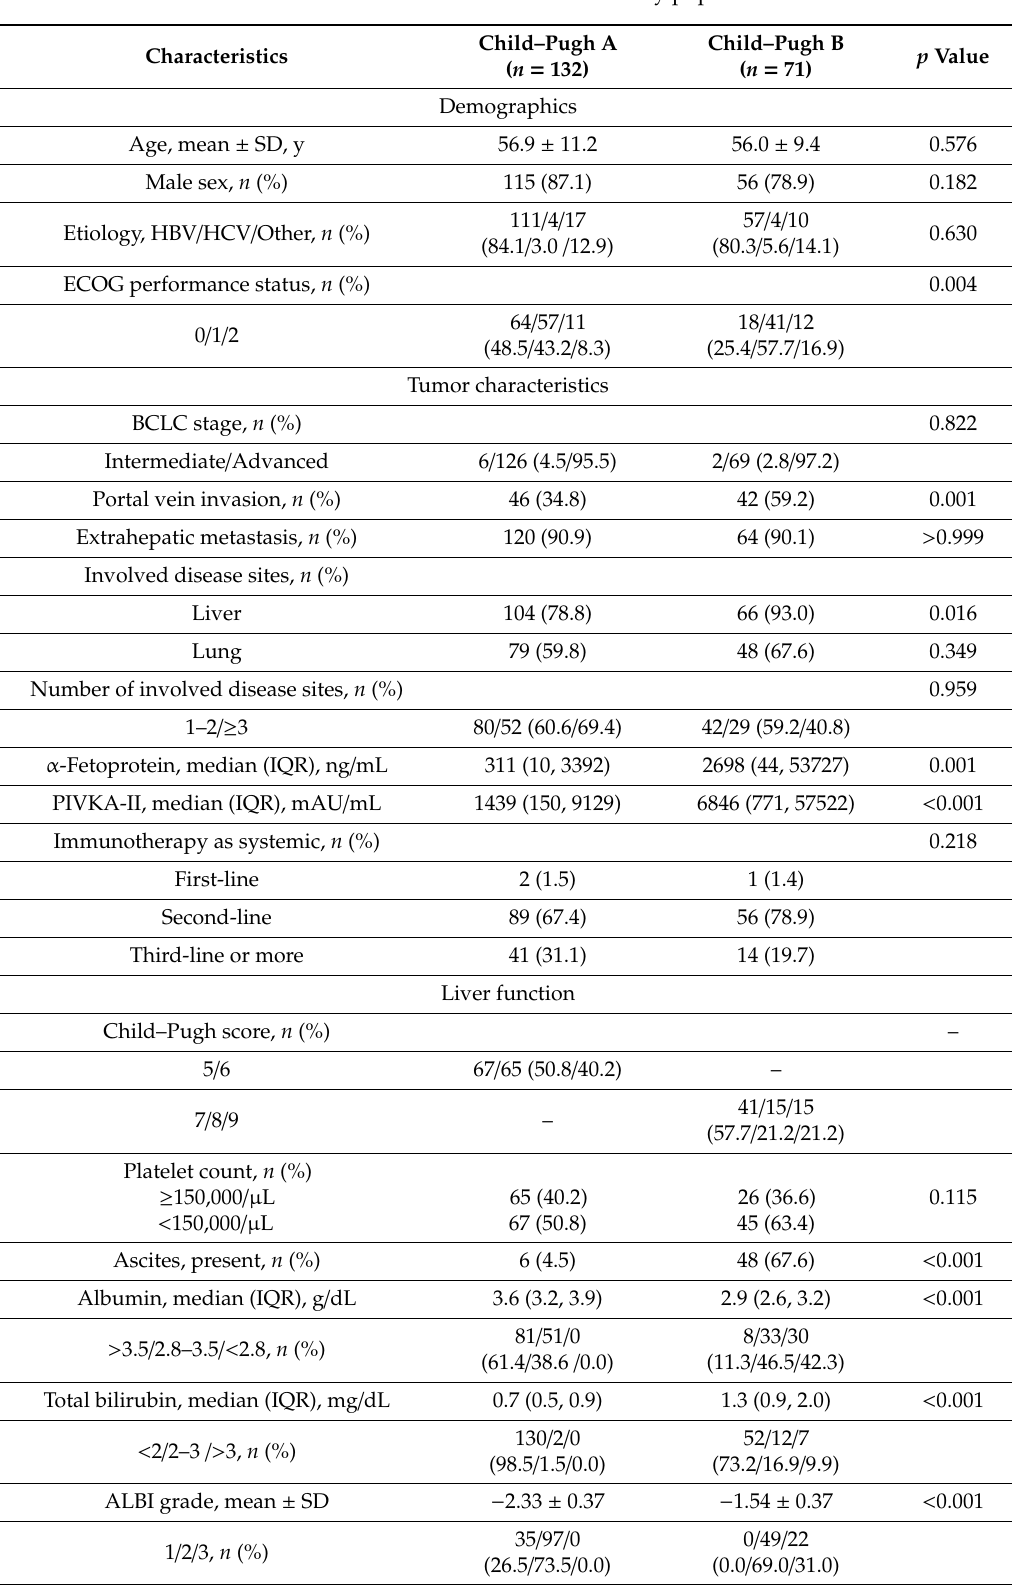
Table 1. Baseline characteristics of the study